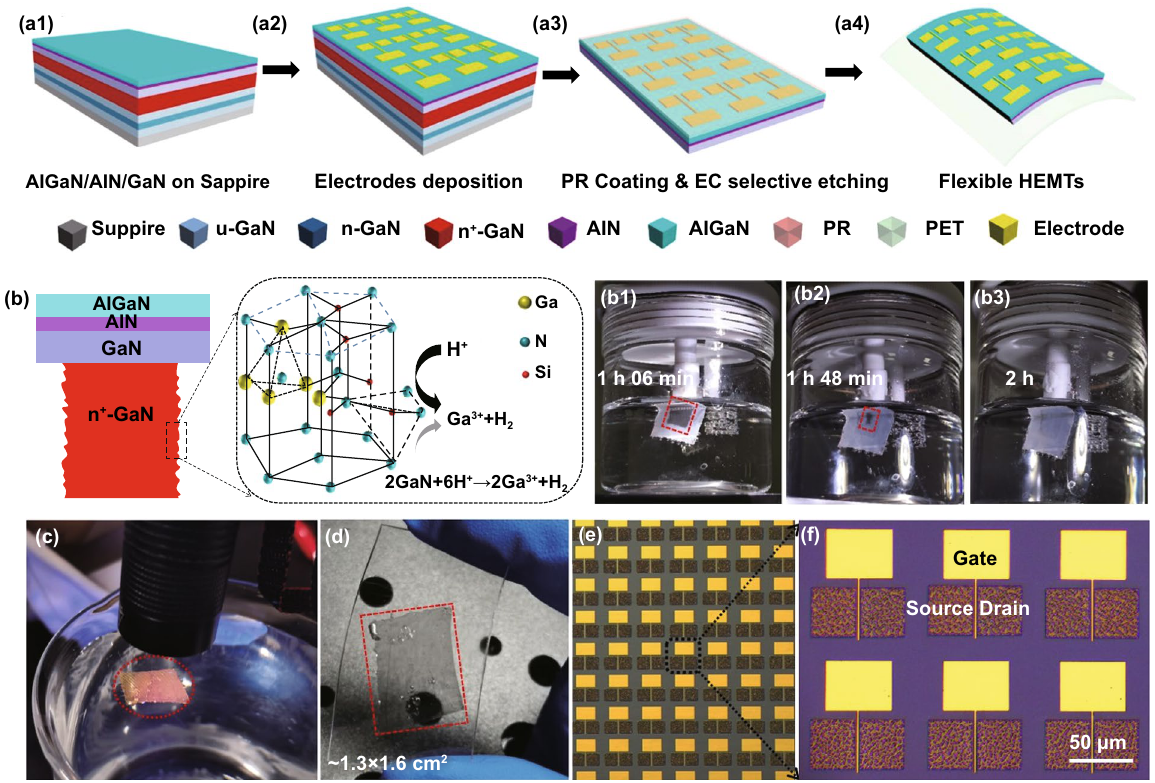
Fig. 3 The HEMTs debonding and transition processes. a1 Epitaxial layers on sapphire. a2 The process of depositing electrodes. a3 After coating photoresist, the selective EC eaching processes to lift-off sapphire. a4 Transferring flexible HEMTs on PET substrate. b The process of lateral undercut eaching sacrificial layers n + -GaN and the etching mechanisms. c , d The optical images of successfully transferred large-area (~ 1.3 × 1.6cm 2 ) and non-destructive HEMTs. e , f The microphotograph of HEMTs